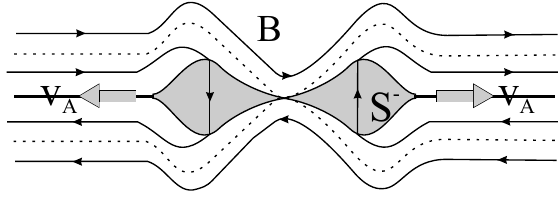
Fig. 1. Geometrical configuration of time-dependent reconnection. Two antiparallel directed magnetic fields are separated by a current sheet. The shocks, denoted by S − , propagate in opposite directions along the current sheet. The shaded regions, enclosed by the shocks, represent the outflow or field reversal regions. The dashed lines de- note the separatrices, which separate regions of different magnetic field topology (after Semenov et al. (2004)).